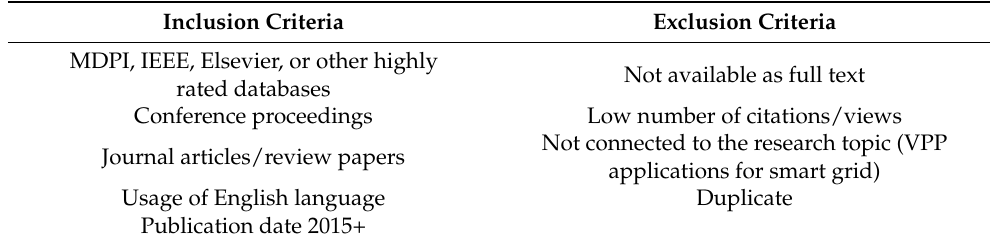
Table 1. Criteria for including and excluding